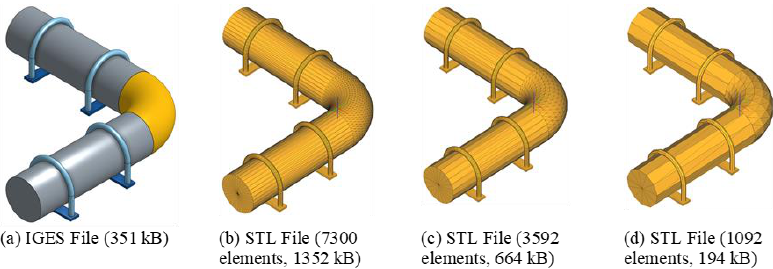
Figure 1. Three-dimensional (3D) computer-aided design (CAD) and lightweight files ( a ) saved in initial graphics exchange specification (IGES) format and ( b )–( d ) saved in stereolithography (STL) format.